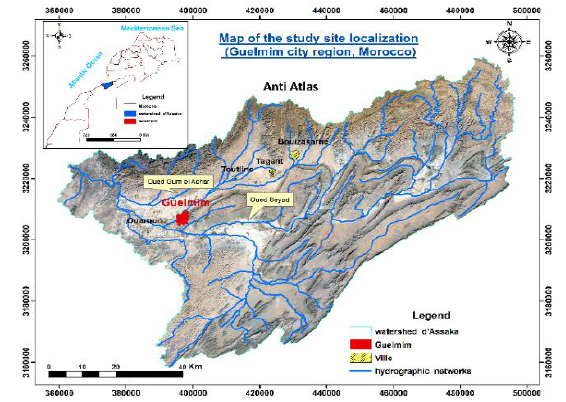
Figure 1. The Geographical Location of the Study